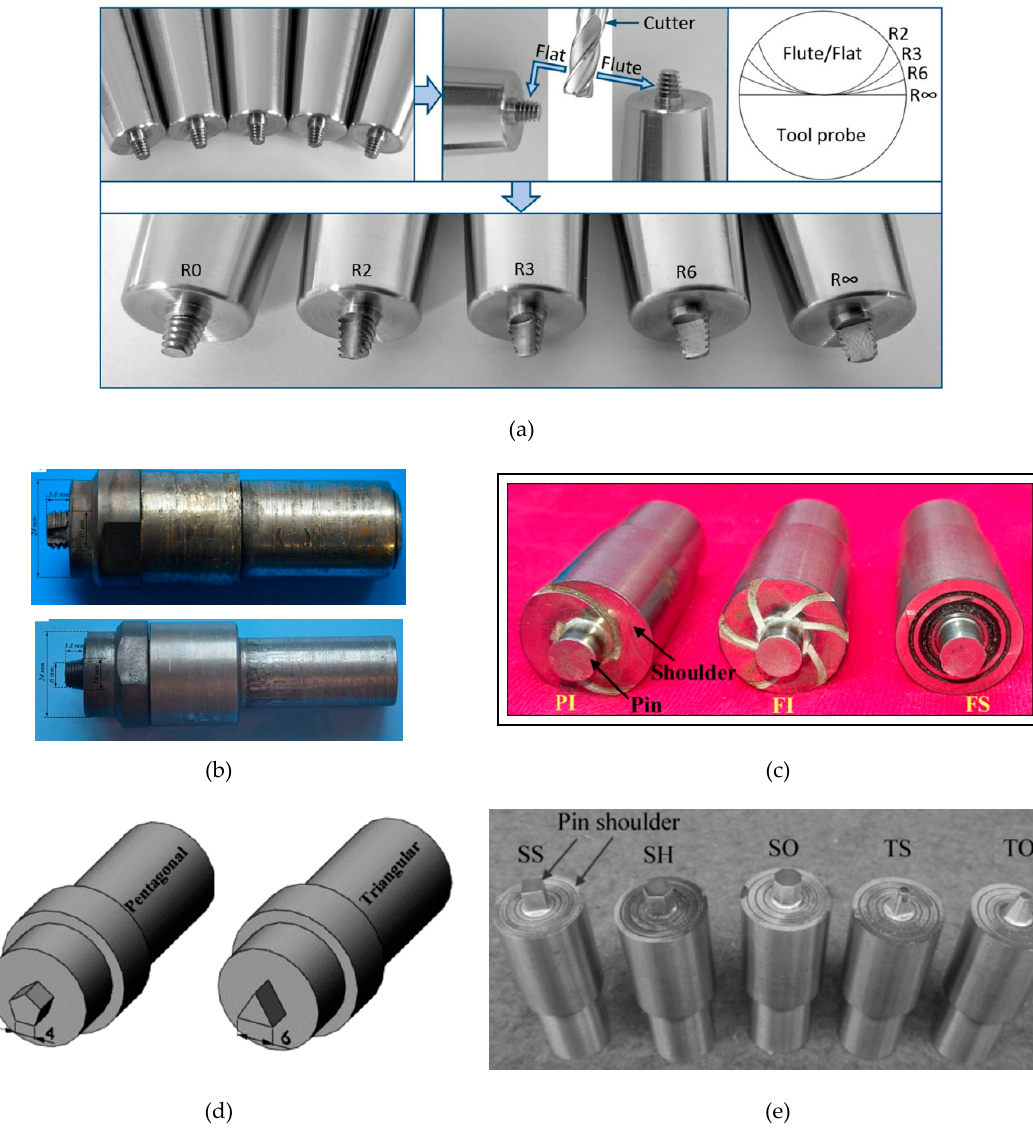
Figure 8 . Tools of different geometries used in different Al alloy combinations. ( a ) AA2024-AA7075, reproduced from [14], with permission from Springer, 2018; ( b ) AA5083-AA7075, reproduced from [16], with permission from Springer, 2018; ( c ) AA5083-AA6351, reproduced from [18], with permission from SAGE, 2018; ( d ) AA5083-AA6082 [34], with permission from the authors; ( e ) AA5083-AA6351 [57], with permission from Springer, 2013.